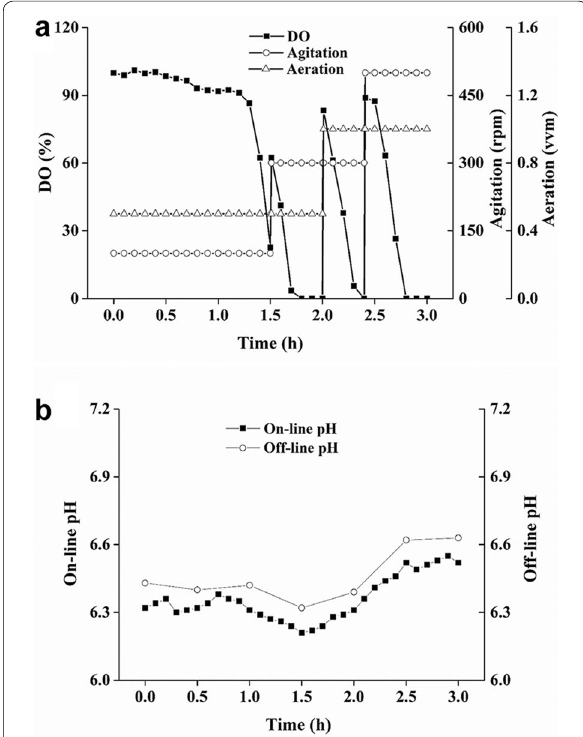
Fig. 4 Time profiles of DO ( a ) and pH ( b ) in E. coli culture with a micro-bioreactor